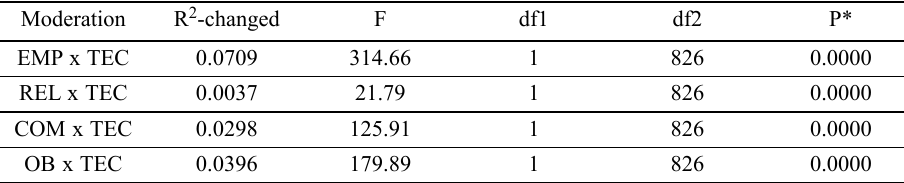
Table 9. Increment in